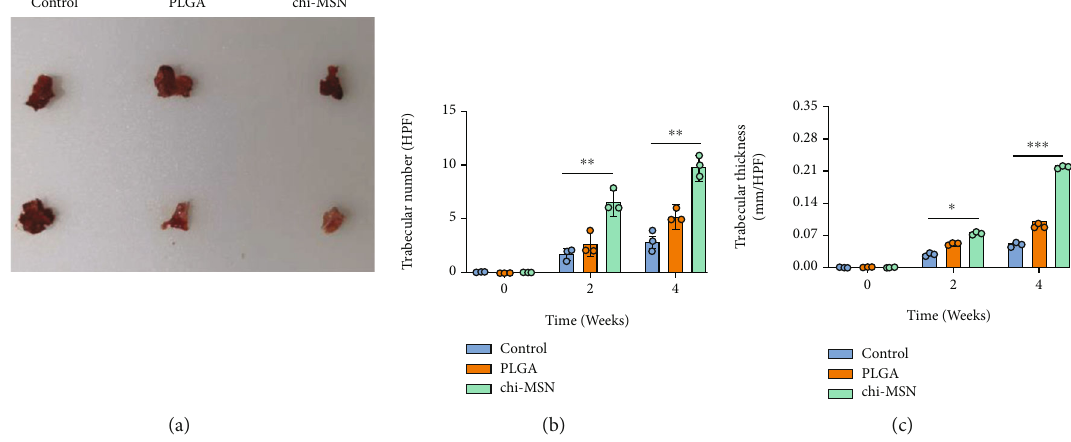
Figure 8: Therapeutic e ff ect of BMP-2@Chi-MSN on bone defect. (a) Macroscopic appearance of lesions in saline, PLGA, or Chi-MSN- treated bone defect mice. (b) Trabecular number of lesions in saline, PLGA, or Chi-MSN-treated bone defect mice. (c) Trabecular thickness of lesions in saline, PLGA, or Chi-MSN-treated bone defect mice. ∗ P < 0 : 05 , ∗∗ P < 0 : 01 , and ∗∗∗ P < 0 : 001 vs. control or PLGA